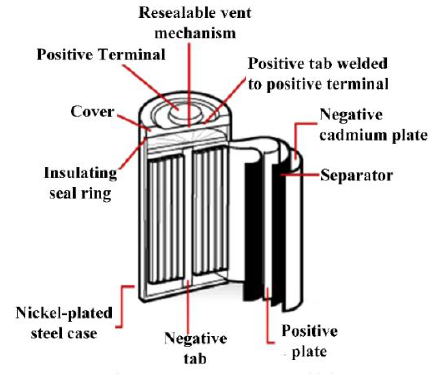
Figure 39. Structure of sealed Nickel-cadmium battery; it is sealed using a metal case, and thus does not leak any gas unless any fault occurs [136].